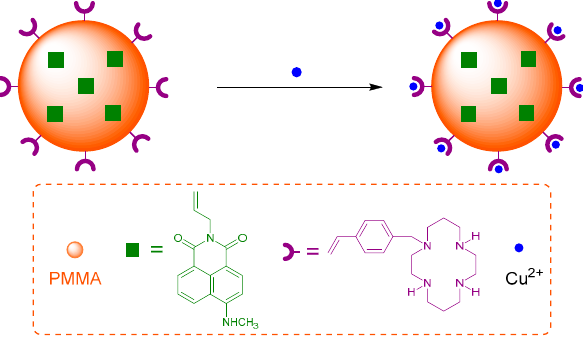
Figure 3. Schematic representation of binding of Cu 2+ to the polymeric nanoparticle 5 , synthesised in one-pot via mini-emulsion polymerisation. The naphthalimide reporter is covalently bound inside the poly(methyl methacrylate) (PMMA) nanoparticle, and the Cu 2+ receptor (vinylbenzylcyclam) is covalently attached to the polymer surface [72].